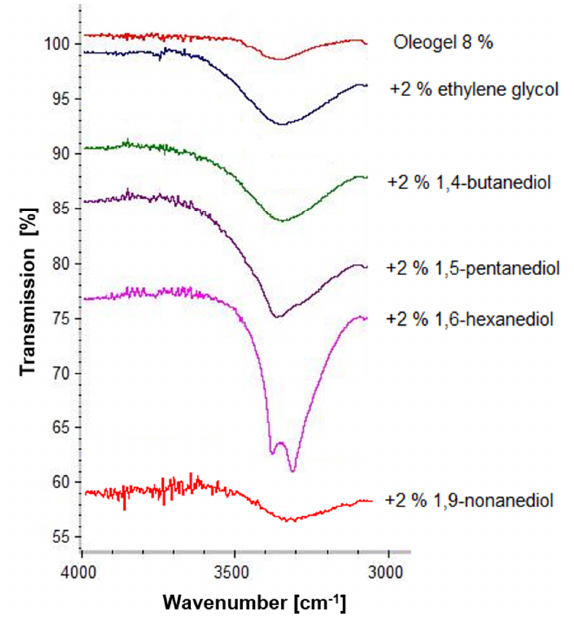
Figure 4. IR spectra of oleogels (8% TE) in sunflower oil with terminal diols (2%).